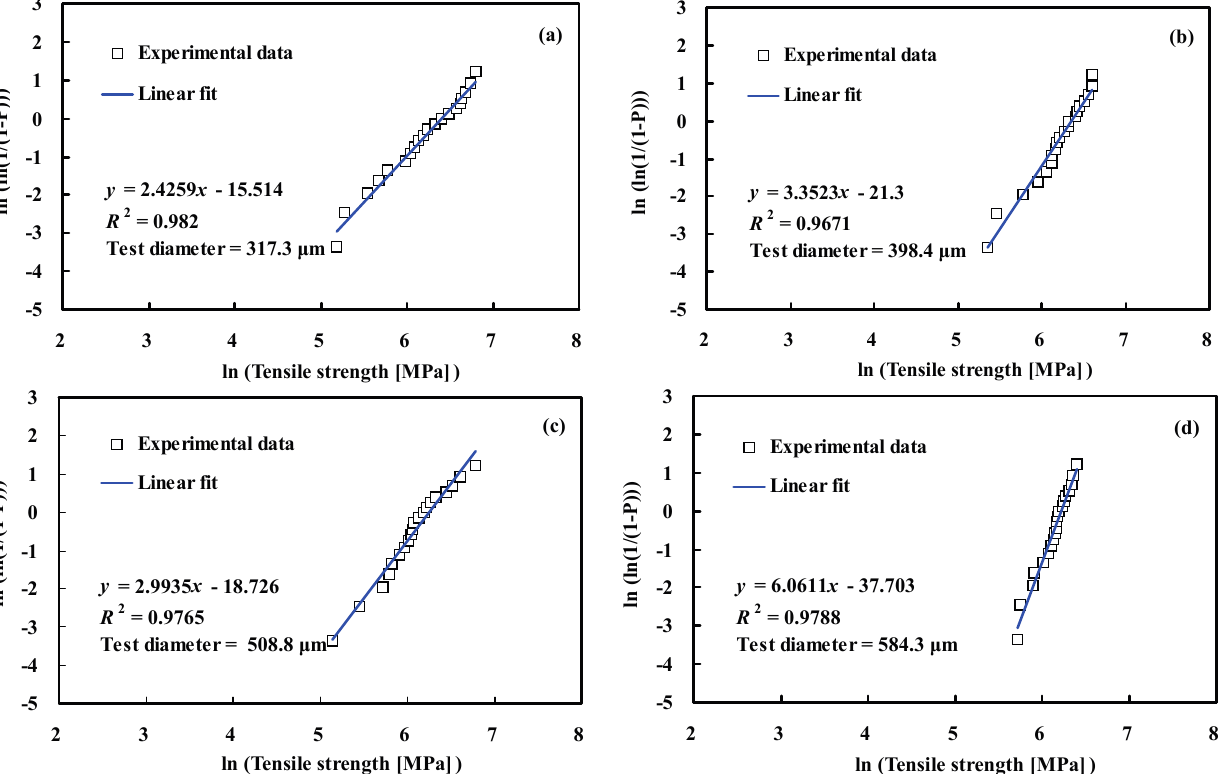
Figure 4. Weibull plots for different test diameters of bamboo fiber: ( a ) 317.3- μ m diameter; ( b ) 398.4- μ m diameter; ( c ) 508.8- μ m diameter; and ( d ) 584.3- μ m diameter.